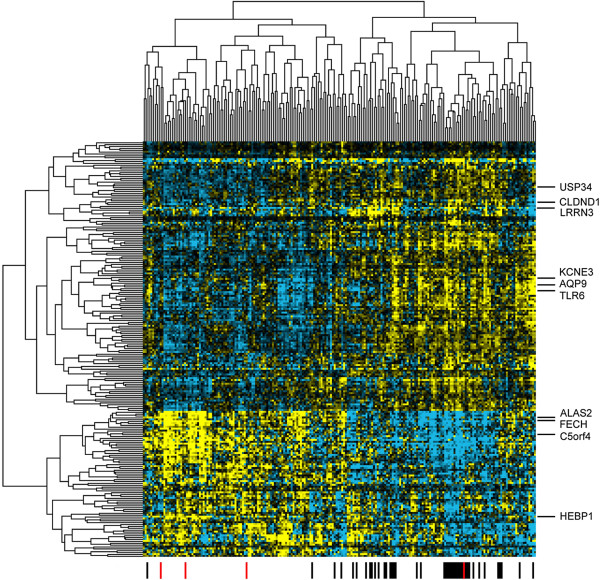
Hierarchical clustering of 209 subjects and 227 array genes associated with smoking (p < 0.001). The dendogram on top shows correlations between subjects; black bars at bottom denote current smokers; red bars denote recently quit smokers. Dendogram on the left shows correlations between genes; positions of representative cell-specific genes are shown on the right.